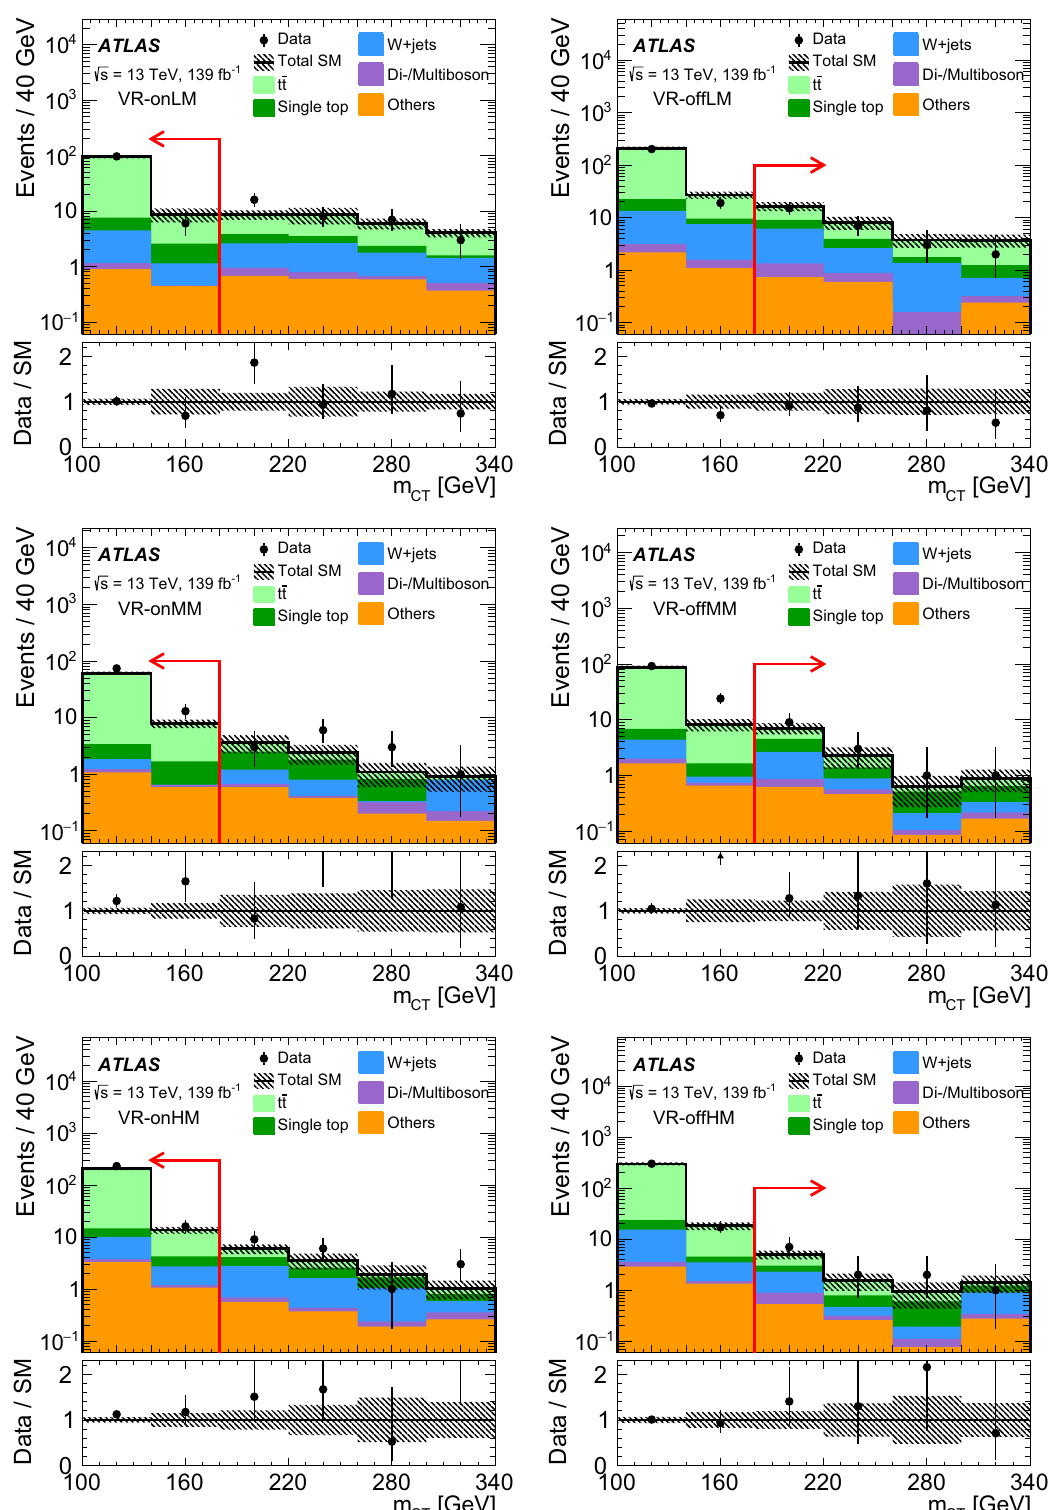
Fig. 3 The post-fit m CT distributions are shown in each of the val- idation regions (VR-onLM, VR-onMM, VR-onHM, VR-offLM, VR- offMM, and VR-offHM) after all the selection requirements are applied other than the m CT cut. The uncertainty bands plotted include all sta-